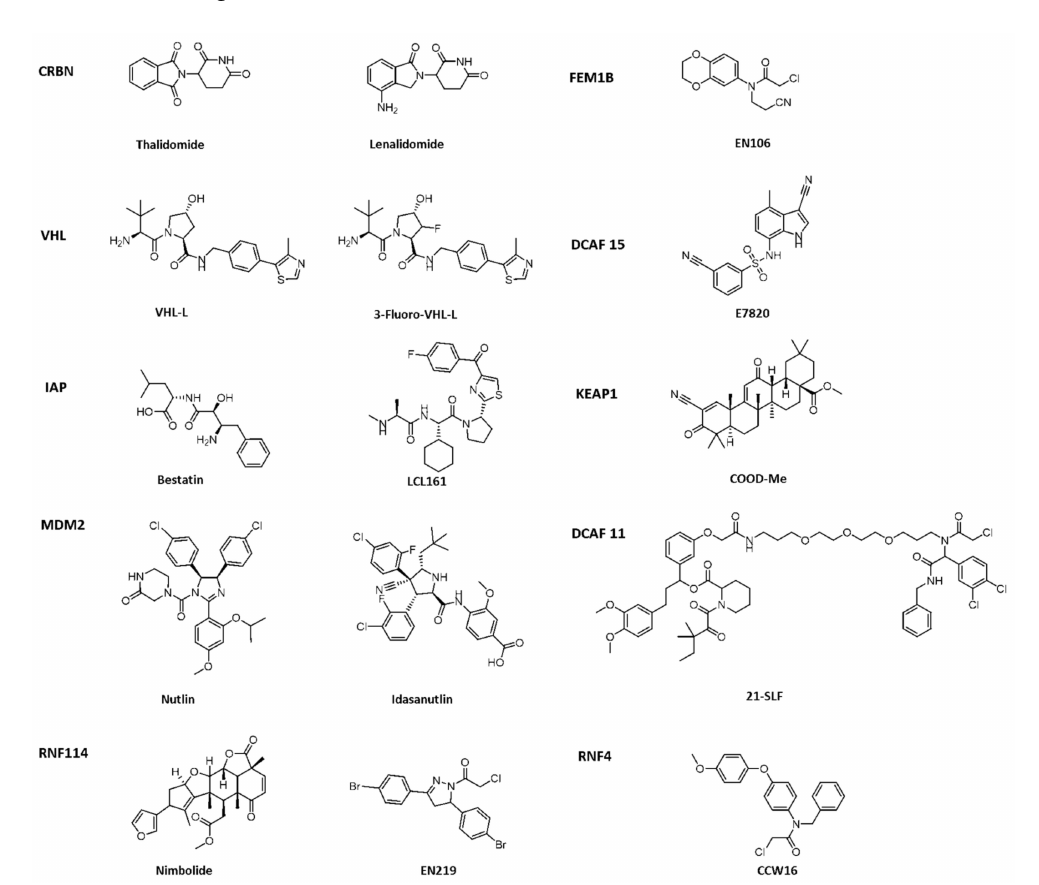
Figure 2. Existing E3 ligands used for targeted protein degradation